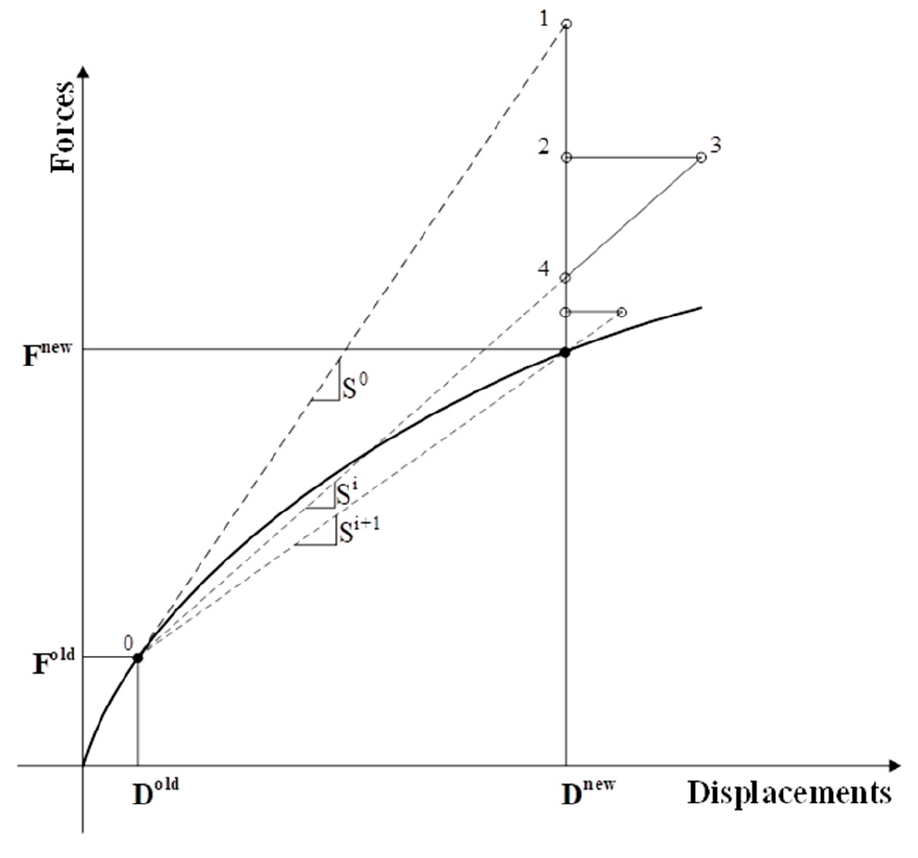
Figure 10. Procedure for the modified Newton–Raphson convergence method. From point “0”, a new incremental displacement is enforced, and the strains and stresses from this last converged point will define the state of the crack. The state of the crack defines which crack is active, forcing the program to only allow that crack to be active for the current iteration. As the state of active crack could, in theory, change within an iteration, the increment of enforced displacement will be made small enough to obtain reasonable results. Figure 11 shows an iterative approach for MNRM